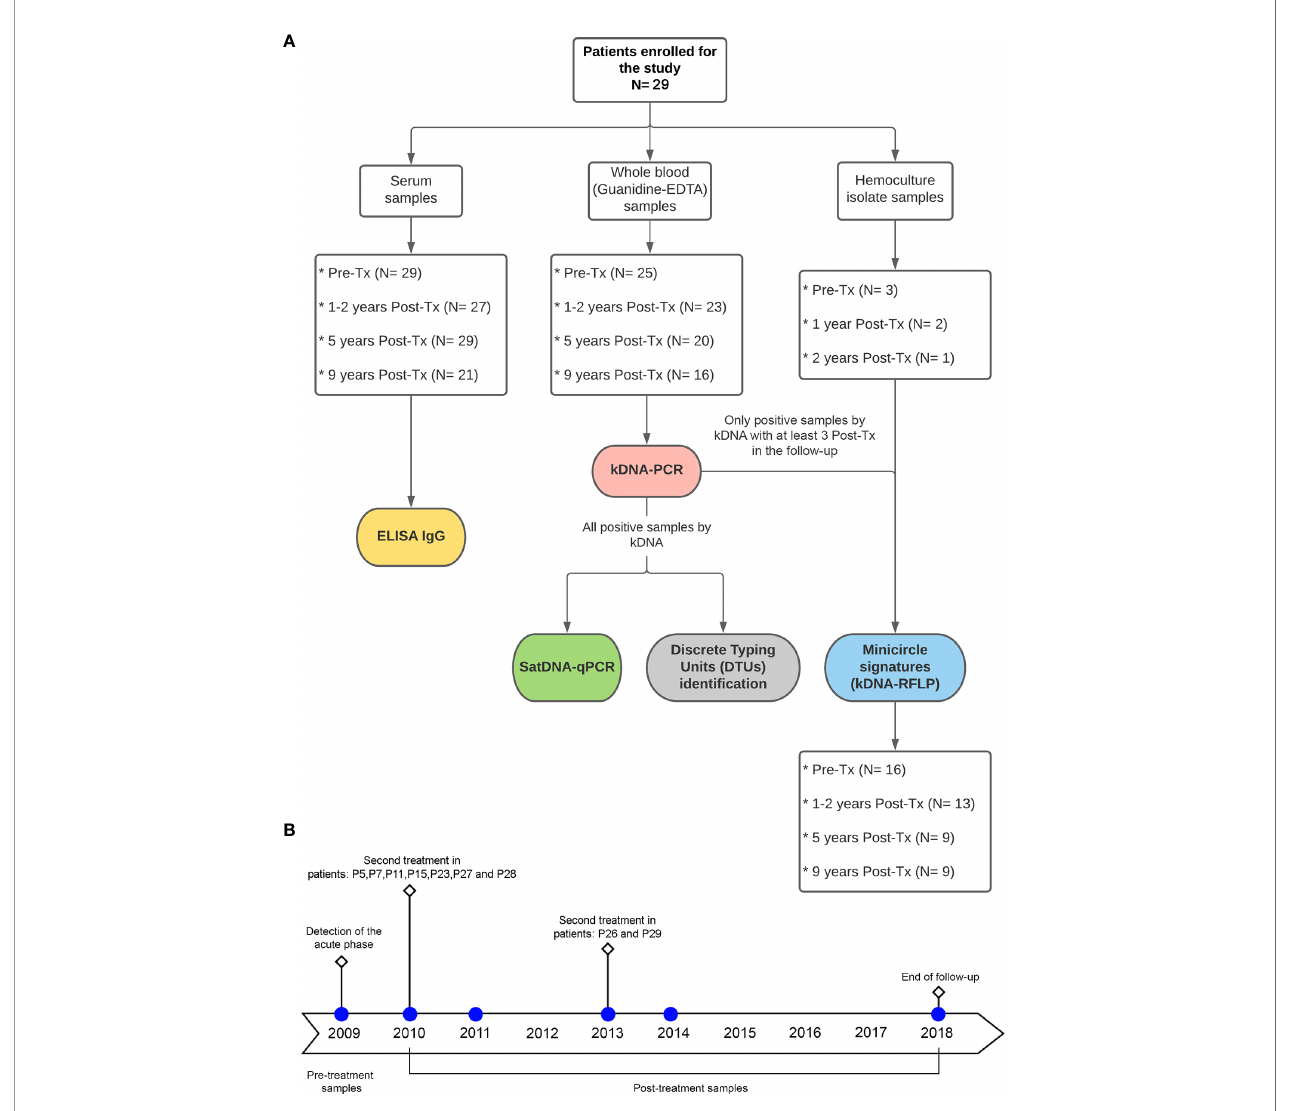
FIGURE 1 | (A) Flowchart for the distribution of study patients´ samples and type of analysis performed. Tx: Treatment. (B) timeline of blood sample collection at follow-up